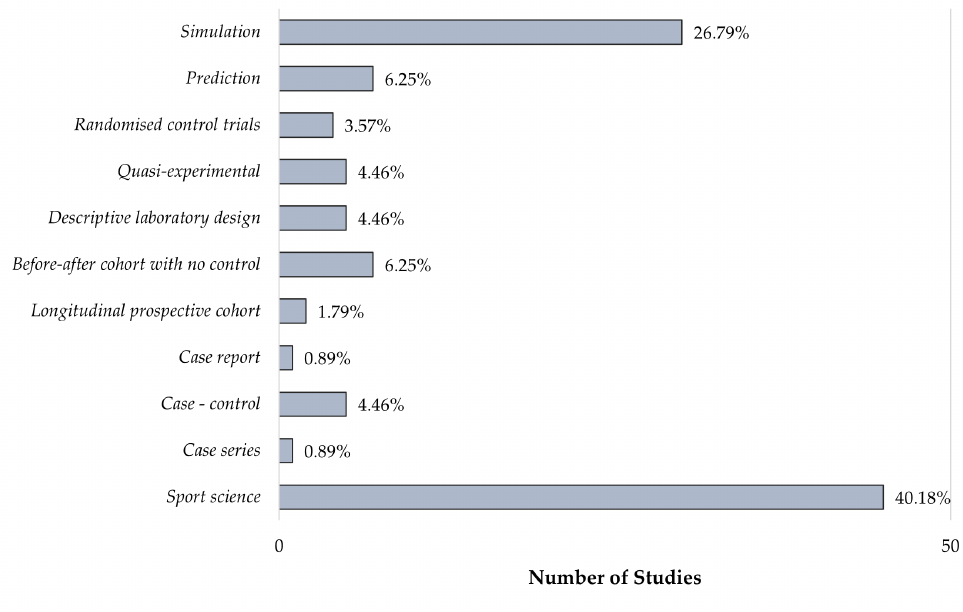
Figure 2. Bar chart of the study design analysis.